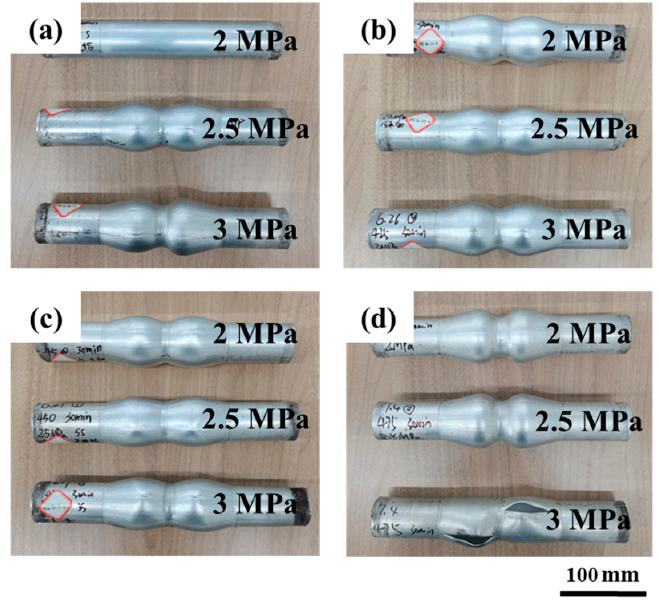
Figure 18. The experimental results of HMGF of 6063 aluminum alloy tube: ( a ) 400 °C; ( b ) 425 °C; ( c ) 450 °C; ( d ) 475 °C.